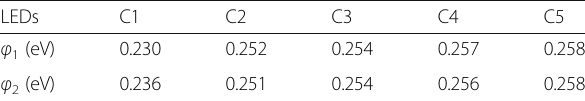
Table 1 Conduction band barrier heights of each NPN-AlGaN junction for LEDs C i ( i = 1, 2, 3, 4, and